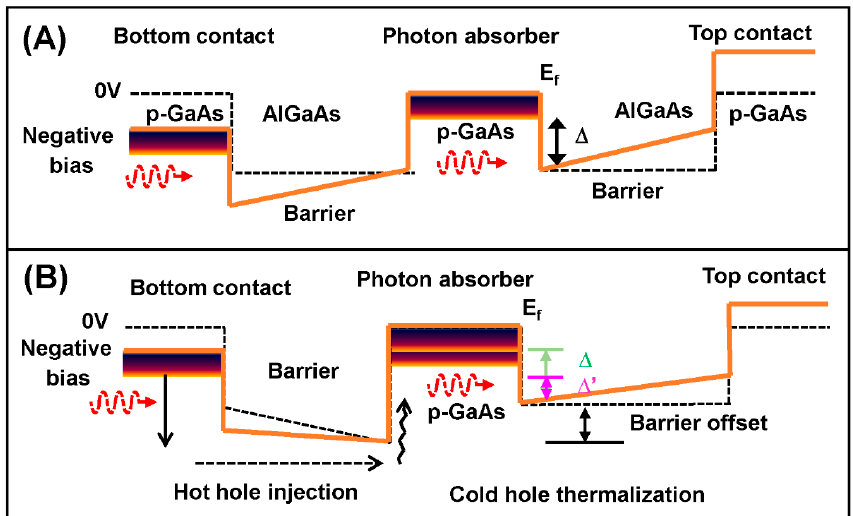
Figure 5. Conventional and wavelength extended photodetector. ( A ) Conventional photodetector. The threshold wavelength ( λ c ) of detection is determined by Δ , where λ c = hc / Δ . ( B ) Wavelength extended photodetector showing barrier offset contributing to wavelength-extended photoresponse.